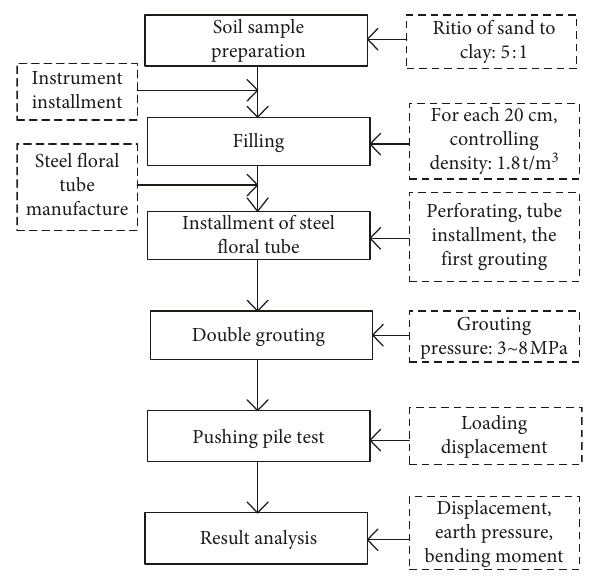
Figure 5: Flow chart of the model test.